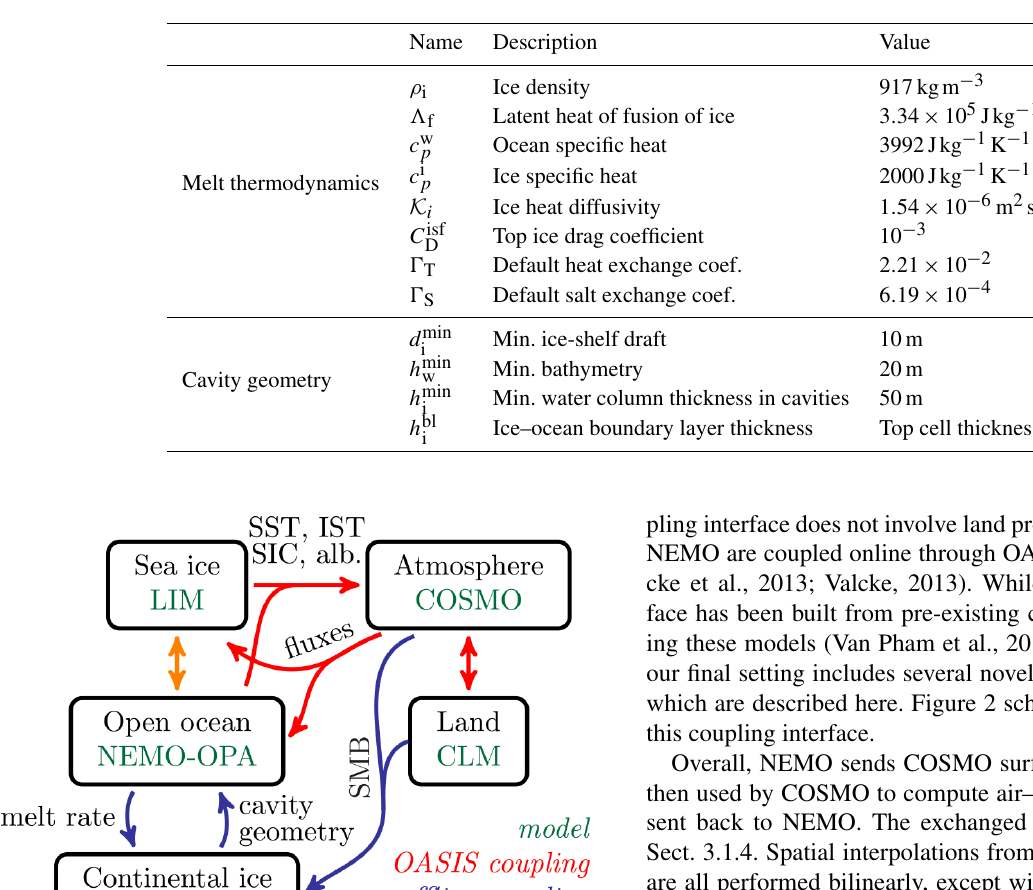
Table 1. NEMO ice-shelf-related physical constants. Here, “ice” refers to the ice sheet (not the sea ice). (cid:48) T and (cid:48) S are taken from Jourdain et al. (2017); ρ i is taken from f.ETISh, the ice-sheet model; all other melt thermodynamics parameters have been kept to their default NEMO values. All cavity geometry parameters have been set from a trade-off between physical realism and numerical stability.